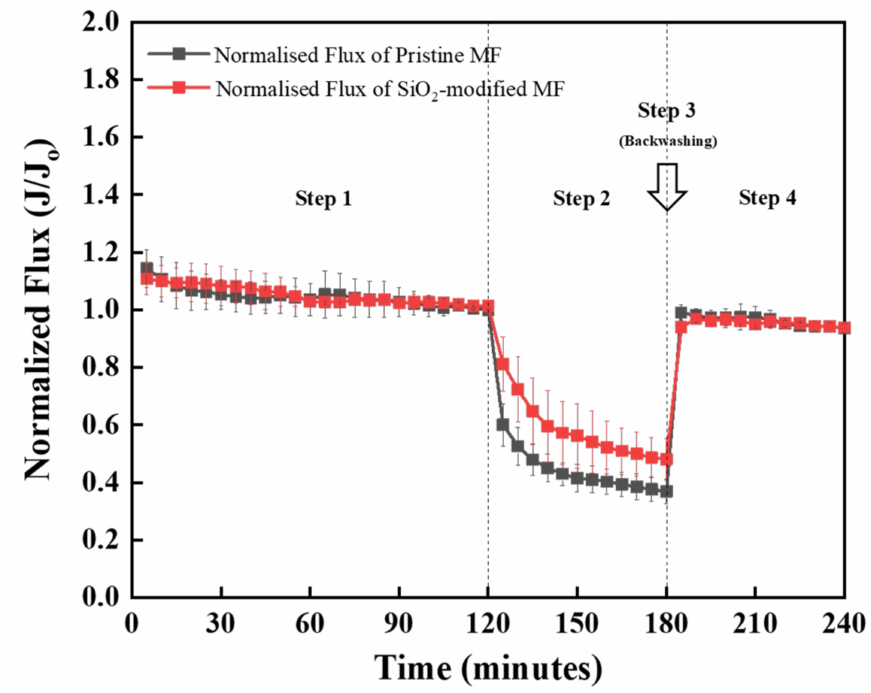
Figure 9. Normalised flux behaviour of pristine microfiltration (MF) membrane and surface-modified microfiltration (MF) membrane with humic acid (HA) solution (10 mg/L, pH